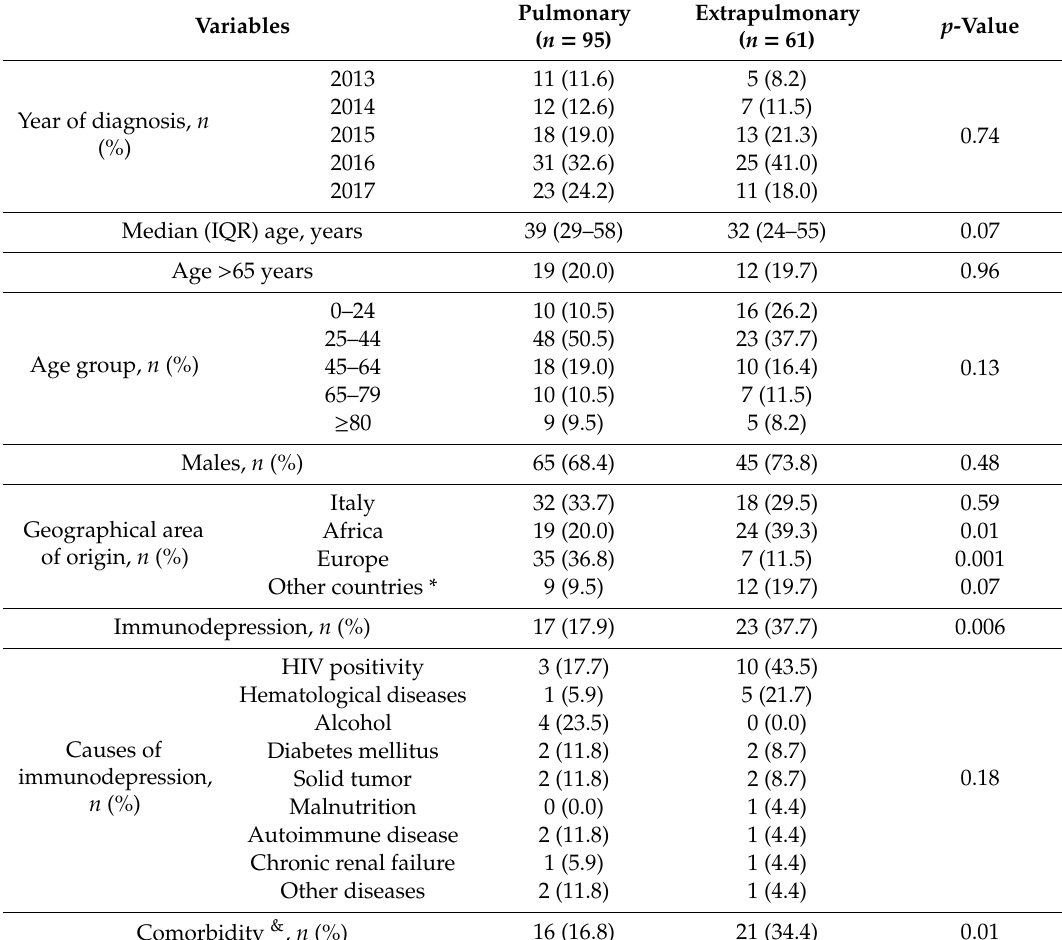
Table 2. Descriptive analysis of patients’ characteristics by pulmonary and extrapulmonary TB